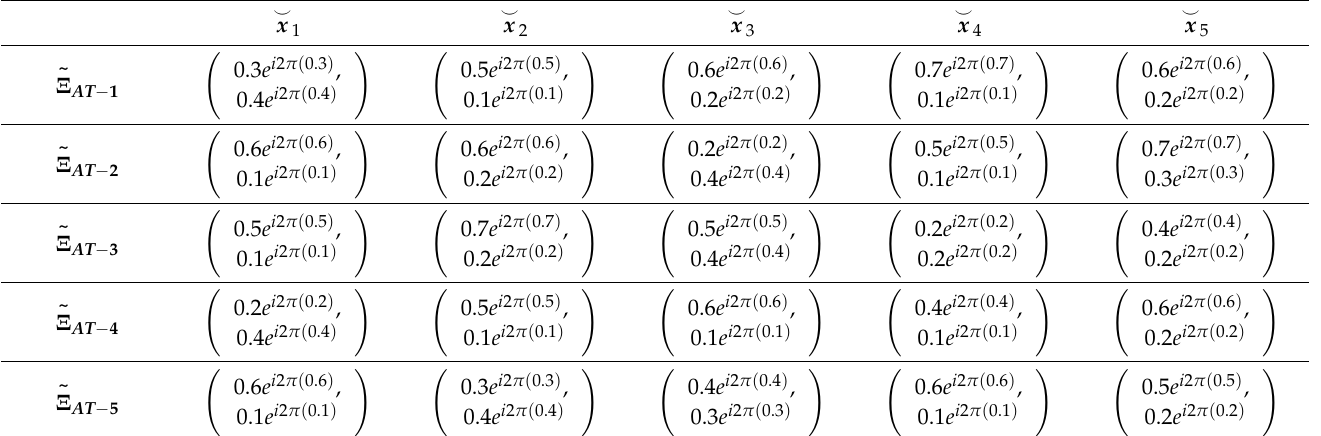
Table 2. Original decision matrix for candidates (cid:101) Ξ CI − 1 .